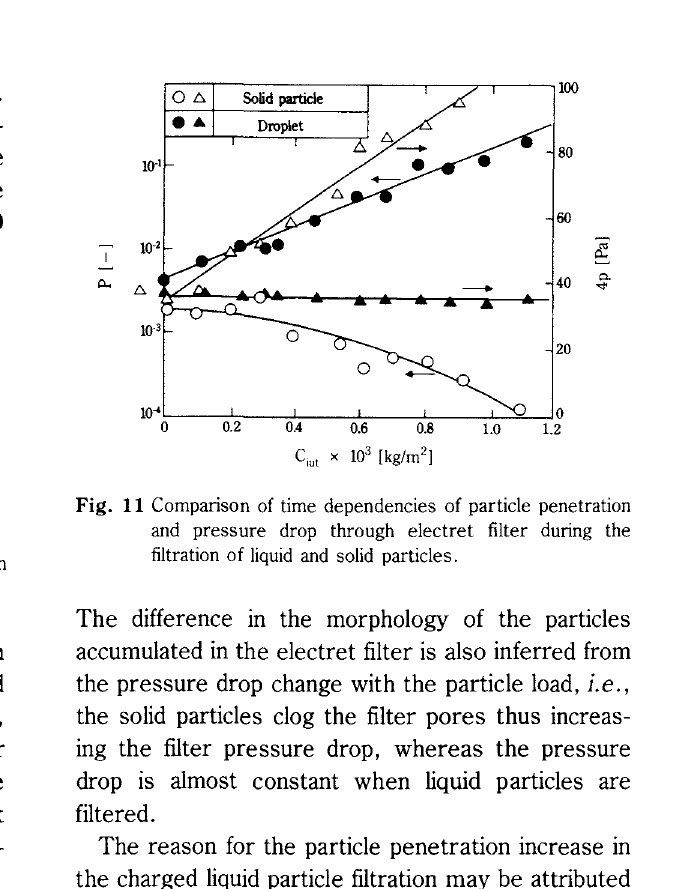
Fig. 10 Influence of humidity on particle penetration through electret filter.